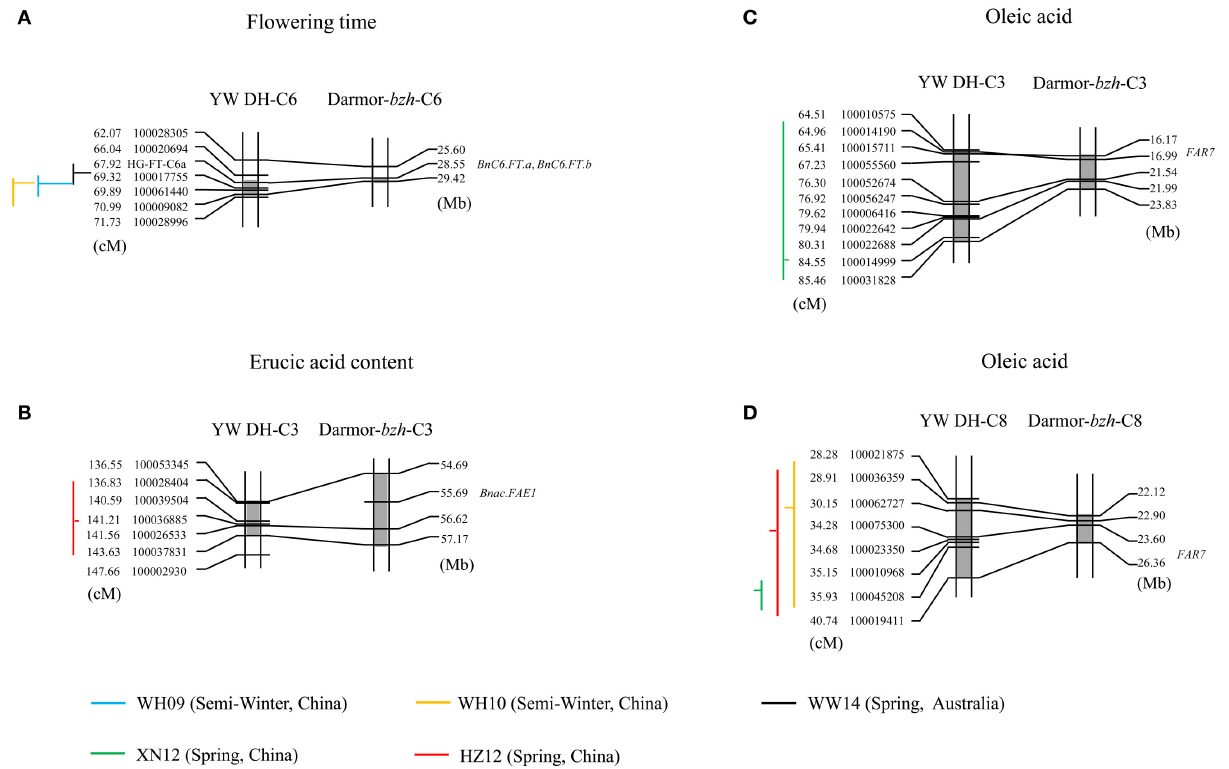
be useful for improvement on the seed quality of B. carinata